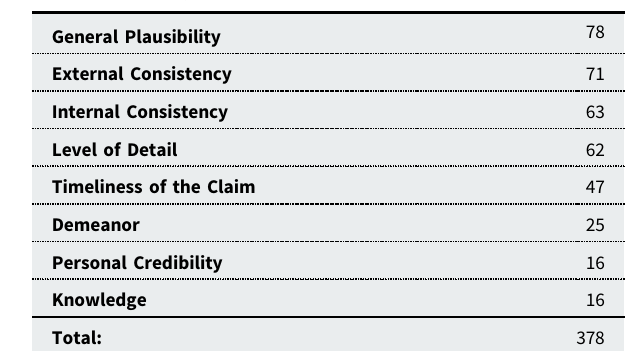
Table 2. Credibility Criteria Used (Total)